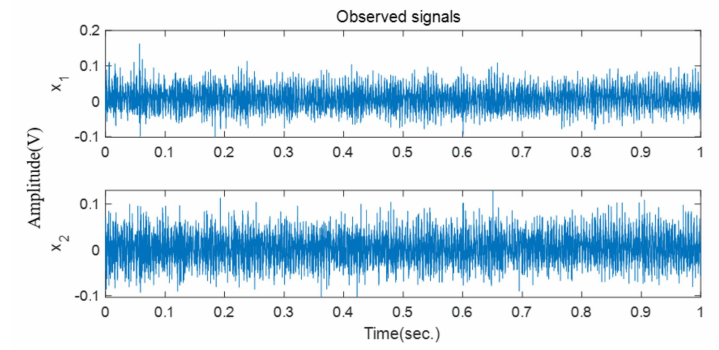
Figure 14. Waveform of the two collected vibration signals in the time domain.